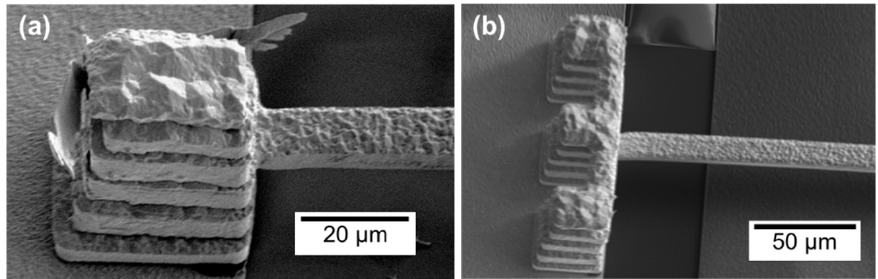
Figure 4. SEM images of the ( a ) block and ( b ) bridge type Ti/Au micro-cantilevers.